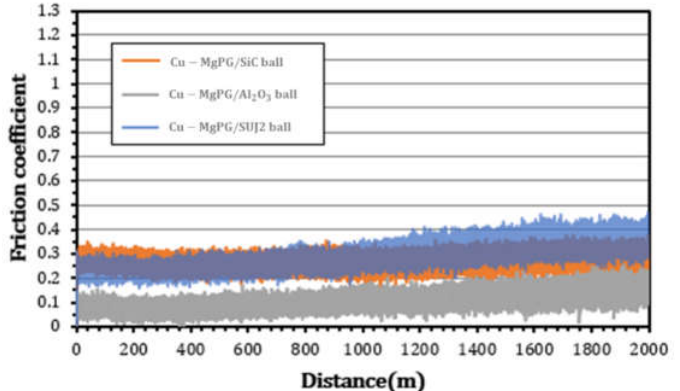
Figure 4. Evolution of friction coefficients of copper/MgP-graphite composites sliding against SiC, Al 2 O 3 , and SUJ2 counterbodies at 10 N.